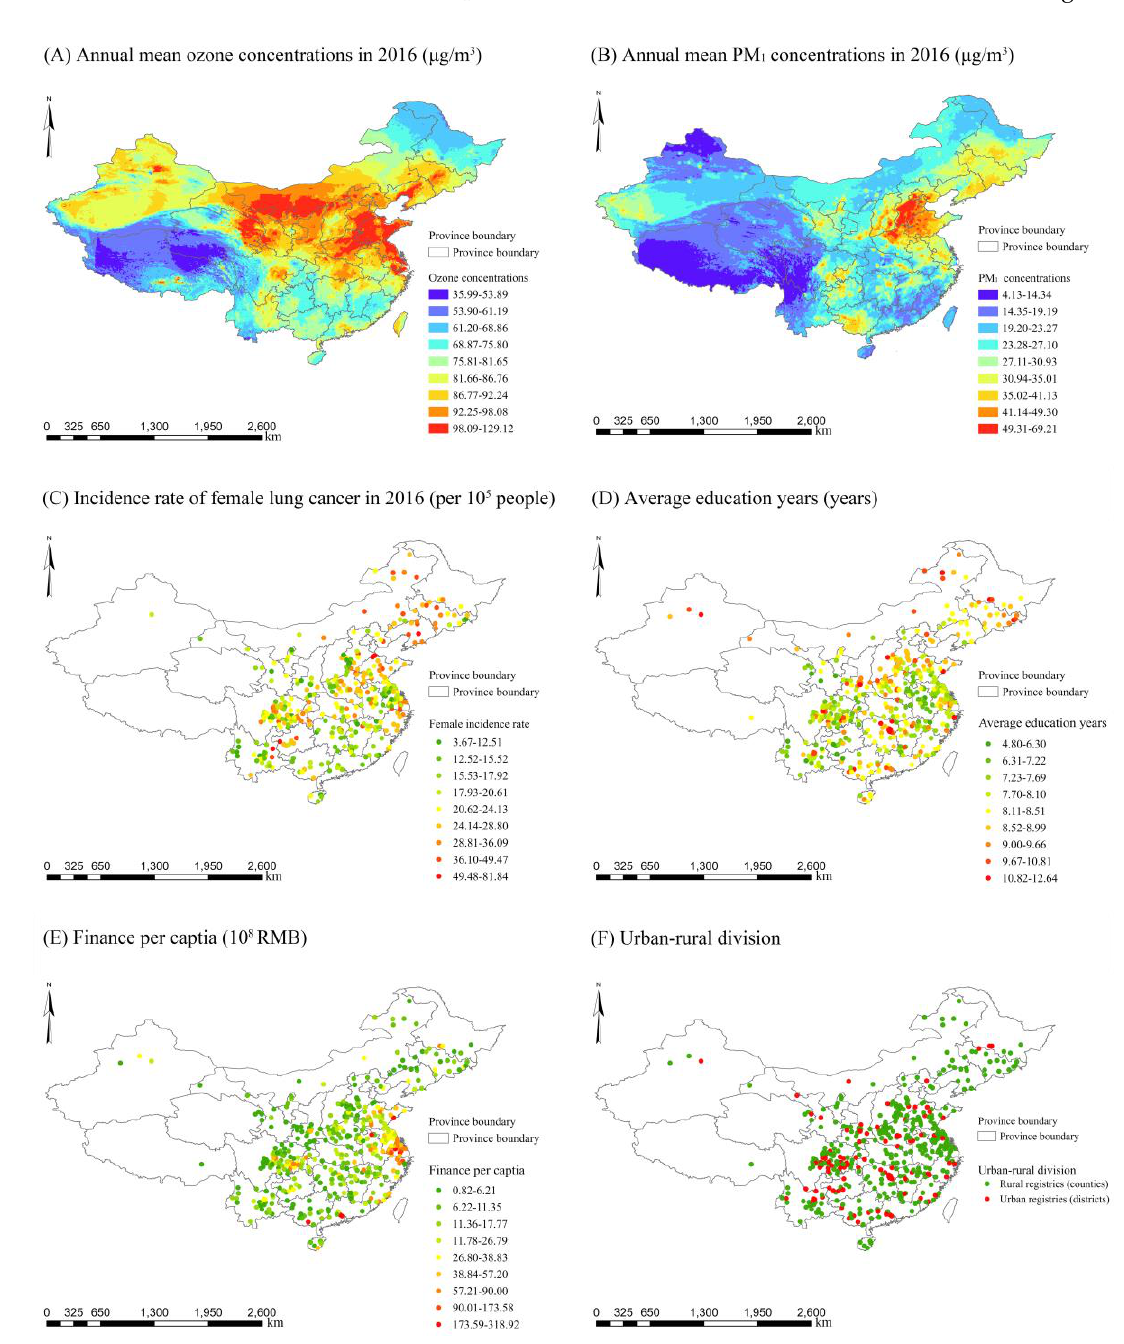
Figure 2. Spatial distributions of annual mean ozone and PM 1 concentrations, the incidence rate of female lung cancer and some socioeconomic covariates.